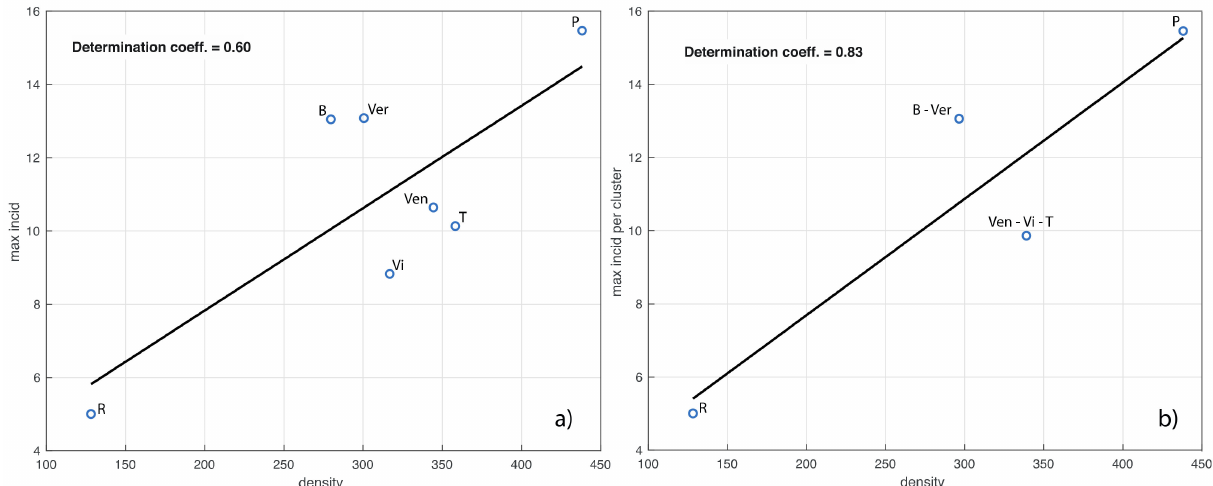
Figure 5. In panel ( a ) we show the linear fit of the maximum value of the province incidence curves in Figure 3 vs. the corresponding population density. In panel ( b ), the provinces are grouped according to the clusters shown in the right panel of Figure 4. The determination coefficients are also shown. The acronyms B, Ver, Ven, T, Vi, P and R stand for Belluno, Verona, Venezia, Treviso, Vicenza, Padua and Rovigo,